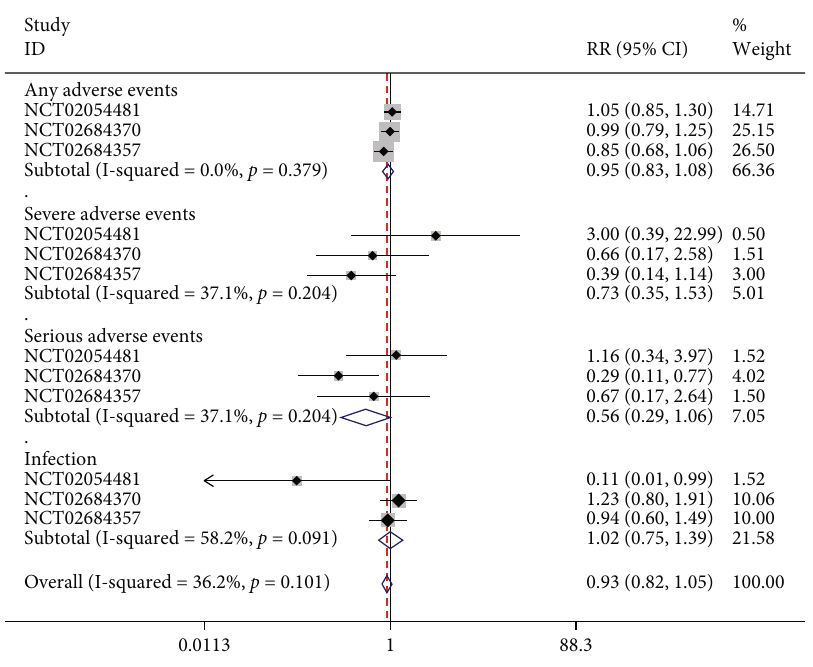
Figure 11: Forest plot of adverse